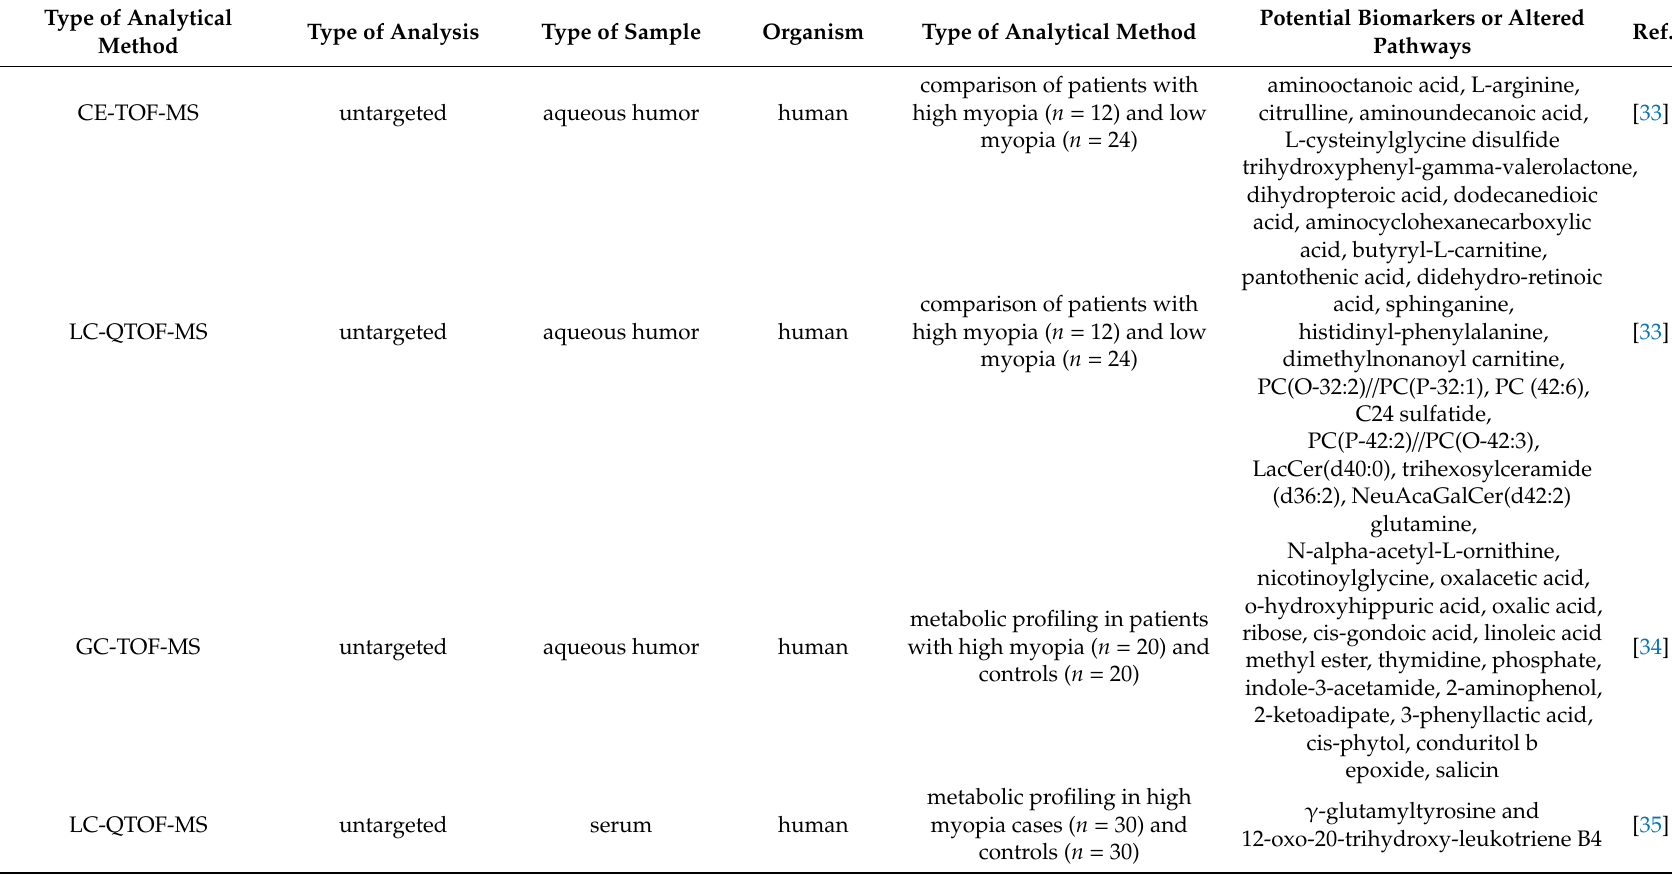
Table 2. Summary of published studies using metabolomic analysis in myopia patients / animal